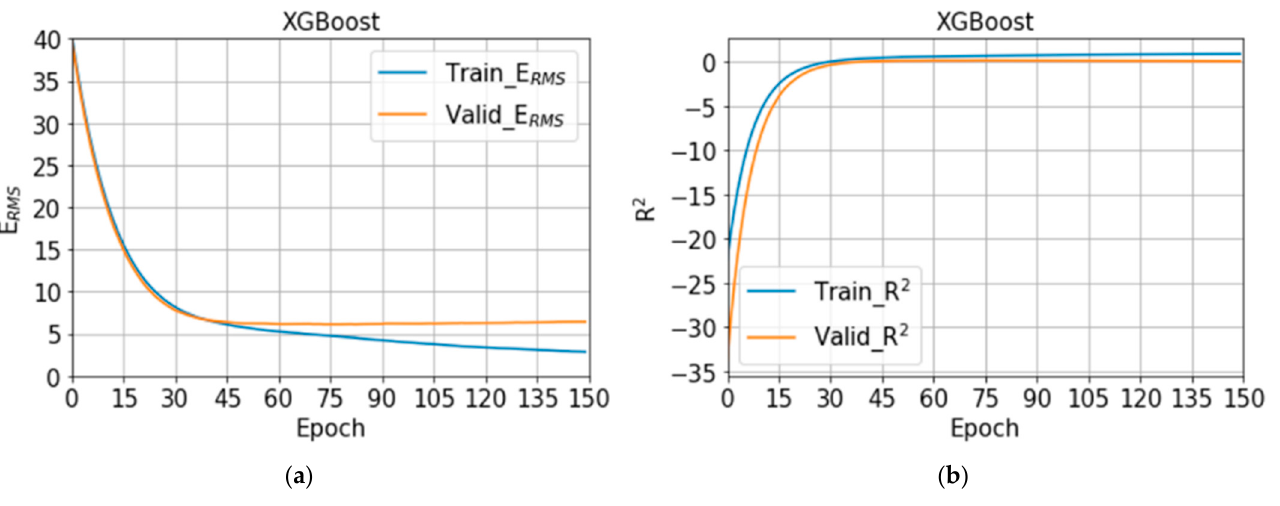
Figure 10. ( a ) The training (blue) and validation (orange) curves of E RMS , ( b ) the training (blue) and validation (orange) curves of R 2 with XGBoost.